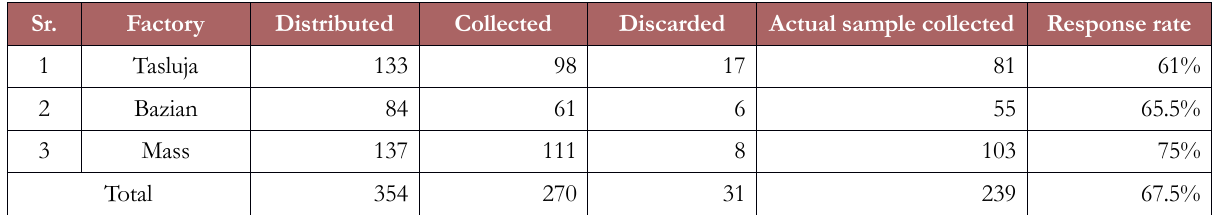
Table 2. Sample Response from Selected